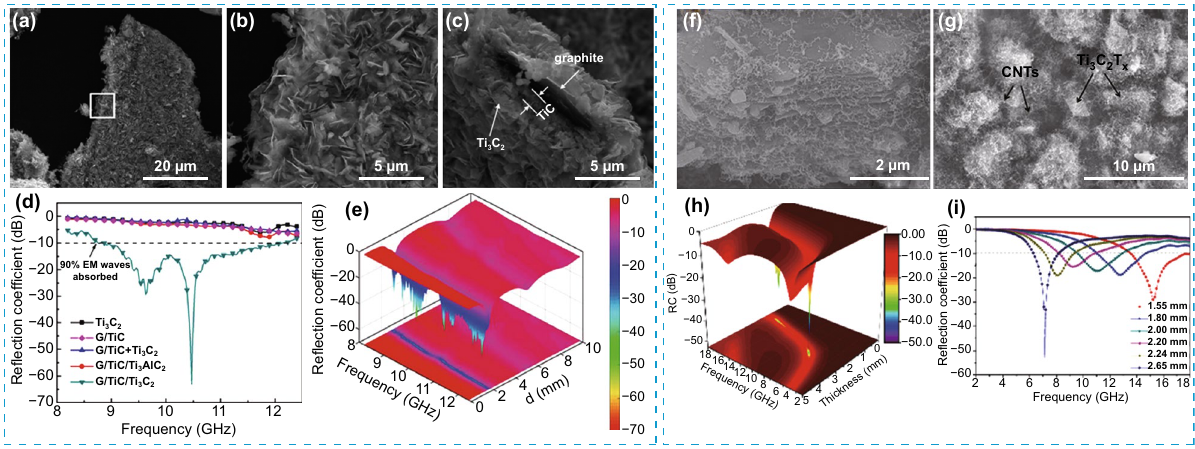
Fig. 10 SEM image of a‑c G/TiC/Ti 3 C 2 T x . d RC of G/TiC/Ti 3 C 2 T x , Ti 3 C 2 T x , G/TiC/Ti 3 AlC 2 , G/TiC, and G/TiC + Ti 3 C 2 T x in paraffin matrix with the loading of 50 wt% with the sample thickness of 2.1 mm. e 3D RC of G/TiC/Ti 3 C 2 T x versus frequency and sample thickness.